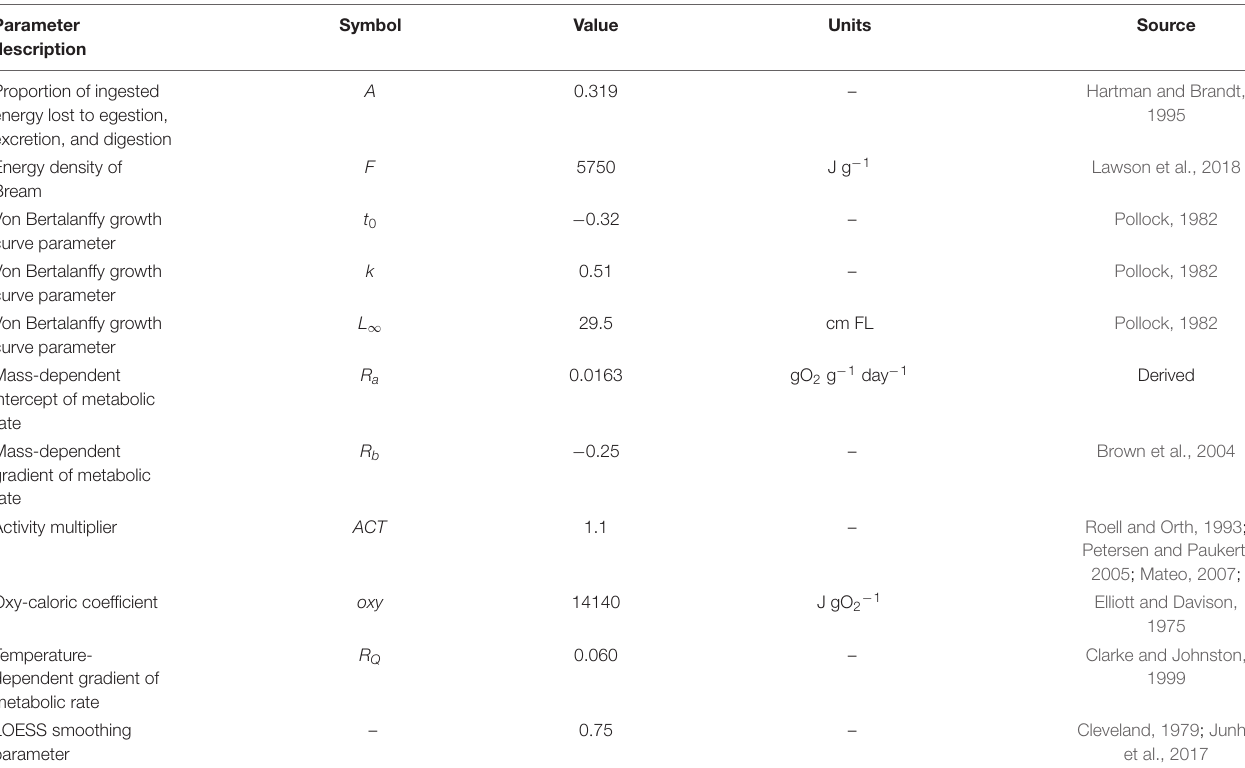
TABLE 1 | Summary of parameter mean values used in the bioenergetic